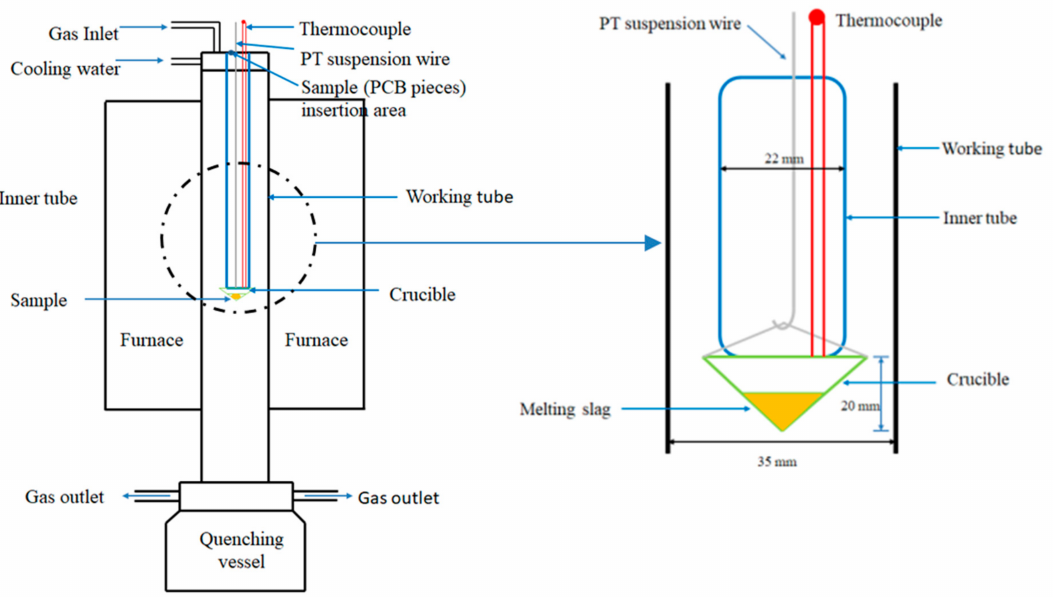
Figure 2. A schematic of the experimental furnace and details of the hot zone. During quenching of the sample, the quenching vessel was lifted to cover the bottom end of the furnace work tube for preserving the inert-gas